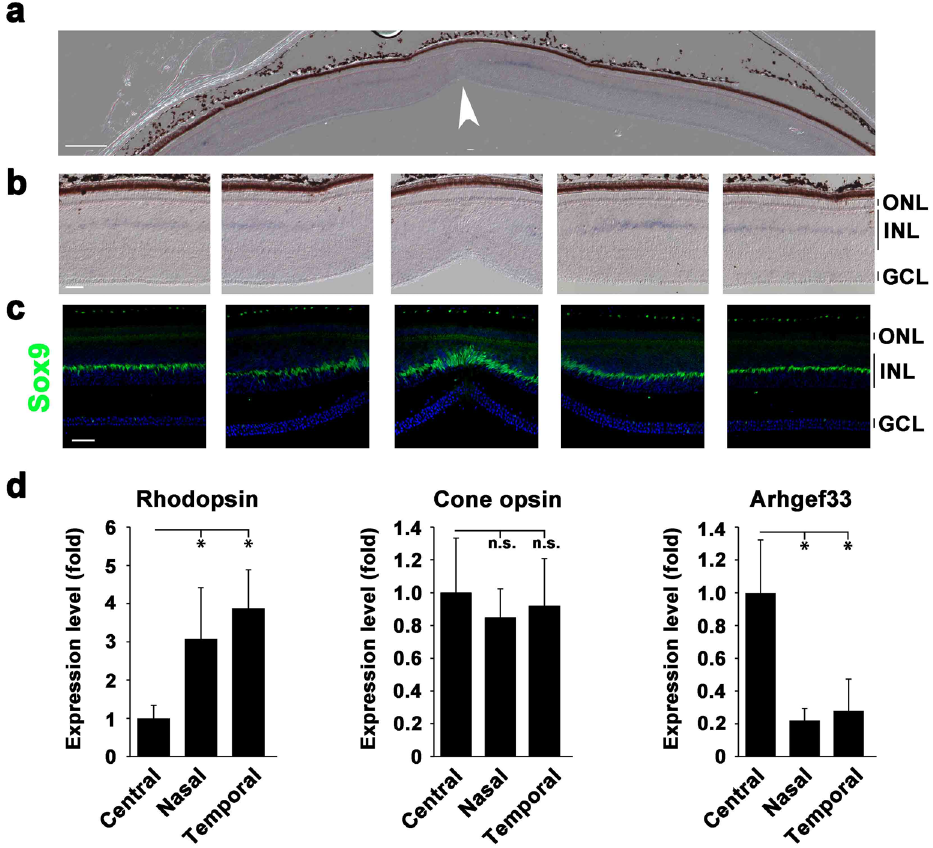
Figure 4. Specific expression of Arhgef33 in the parafovea of the P14 zebra finch retina. ( a ) In situ hybridization analysis of Arhgef33 expression in the zebra finch retina at P14. The arrowhead indicates a foveal pit. Scale bar = 200 μm. ( b ) Higher magnification images of the fovea (center) and parafovea (left, left center, right center, right). The Arhgef33 expression was observed in the middle layer of the INL in the parafovea, while the Arhgef33 expression was absent at the center of the fovea. Scale bar = 50 μm. ONL, outer nuclear layer; INL, inner nuclear layer; GCL, ganglion cell layer. ( c ) Immunostaining of P14 zebra finch retinal sections using an anti-Sox9 antibody (green) and DAPI (blue). Sox9 signal was detected in the middle layer of the INL. Scale bar = 50 μm. ( d ) Expression levels of Rhodopsin (left panel), Cone opsin (middle panel), and Arhgef33 (right panel) were measured by RT-qPCR using RNAs purified from the foveal, nasal, and temporal regions of P14 zebra finch retinas. Rhodopsin expression was up-regulated in the nasal and temporal regions, while Cone opsin expression levels were not significantly different between each region. Arhgef33 expression was up-regulated in the foveal region. Significant differences assessed using a Mann–Whitney U test are marked by an asterisk (n = 5; one retina of each bird). n.s., not